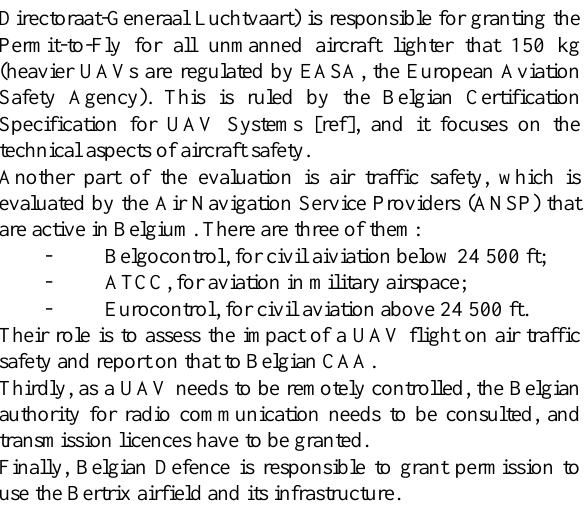
Figure 1. Mercator being prepared at Bertrix